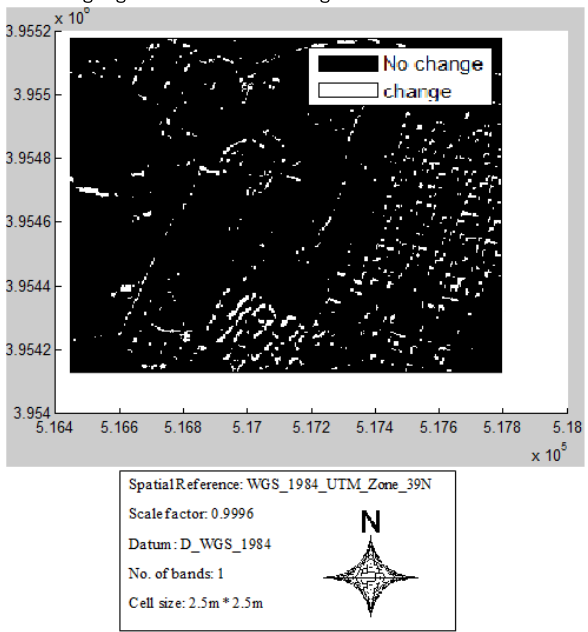
Figure 7. The change image map produced using K-means clustering algorithm